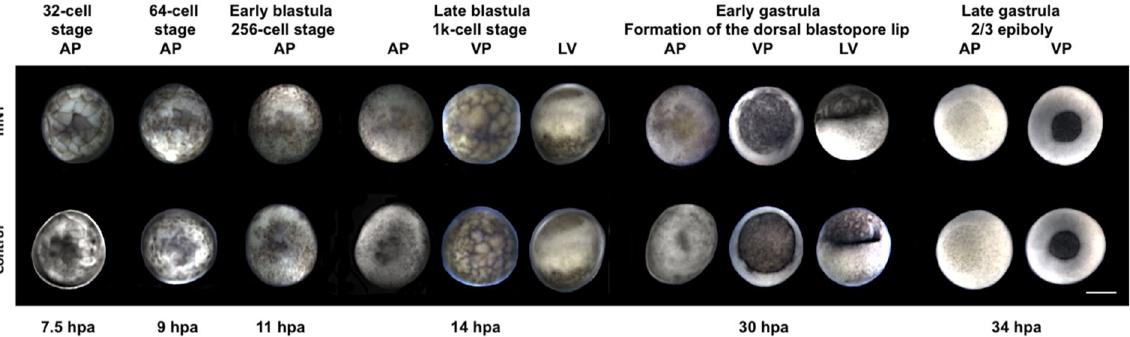
Figure 3. Comparison of the embryonic development between a beluga mNT and a sterlet control embryo. The embryonic stages, from early developmet (32-cell stage) until late gastrula (2/3 epiboly) are presented with the respective hours post activation (hpa) of the eggs. Animal pole (AP), vegetal pole (VP), lateral view (LV), scale bar corresponds to 1